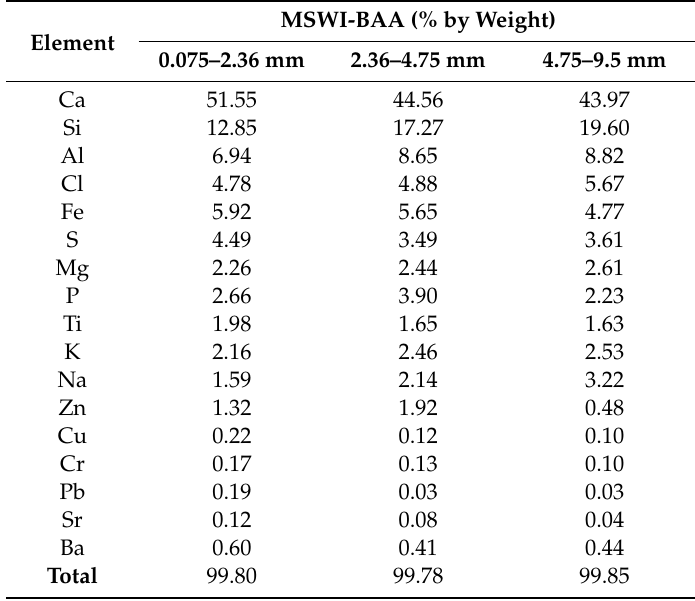
Table 1. XRF analysis results of MSWI-BAA